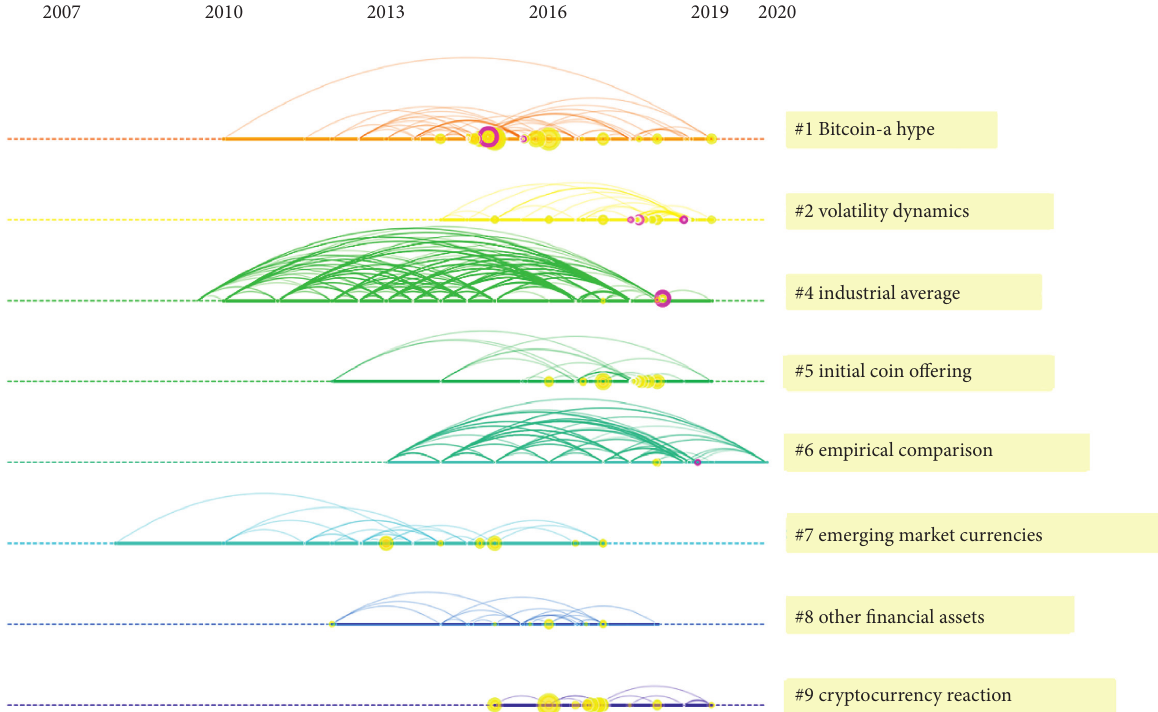
Figure 5: Timelines of cocitation clusters. Major clusters are labeled on the right with different colors. Yellow circles on the horizontal lines represent high citation articles and purple circles denote high betweenness